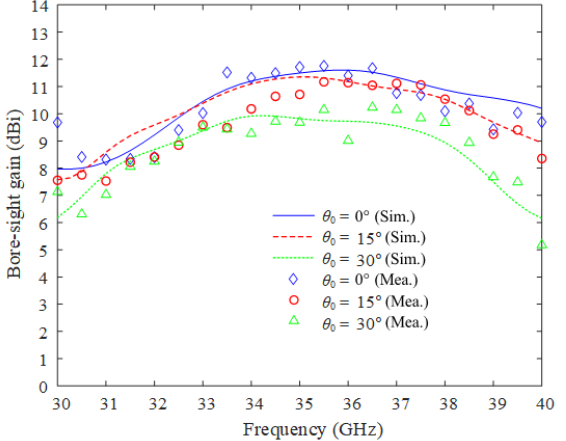
Figure 8. Measured bore-sight gains at different beam-steering